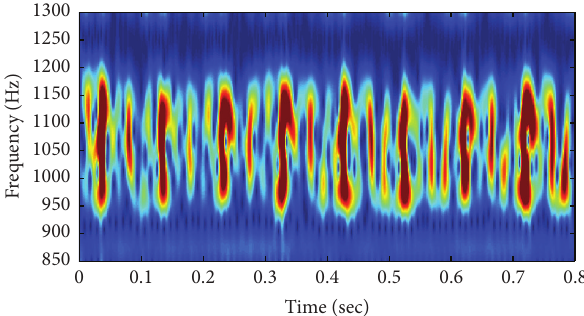
Figure 8: FSWT time-frequency distribution over the band of 850– 1300 Hz.